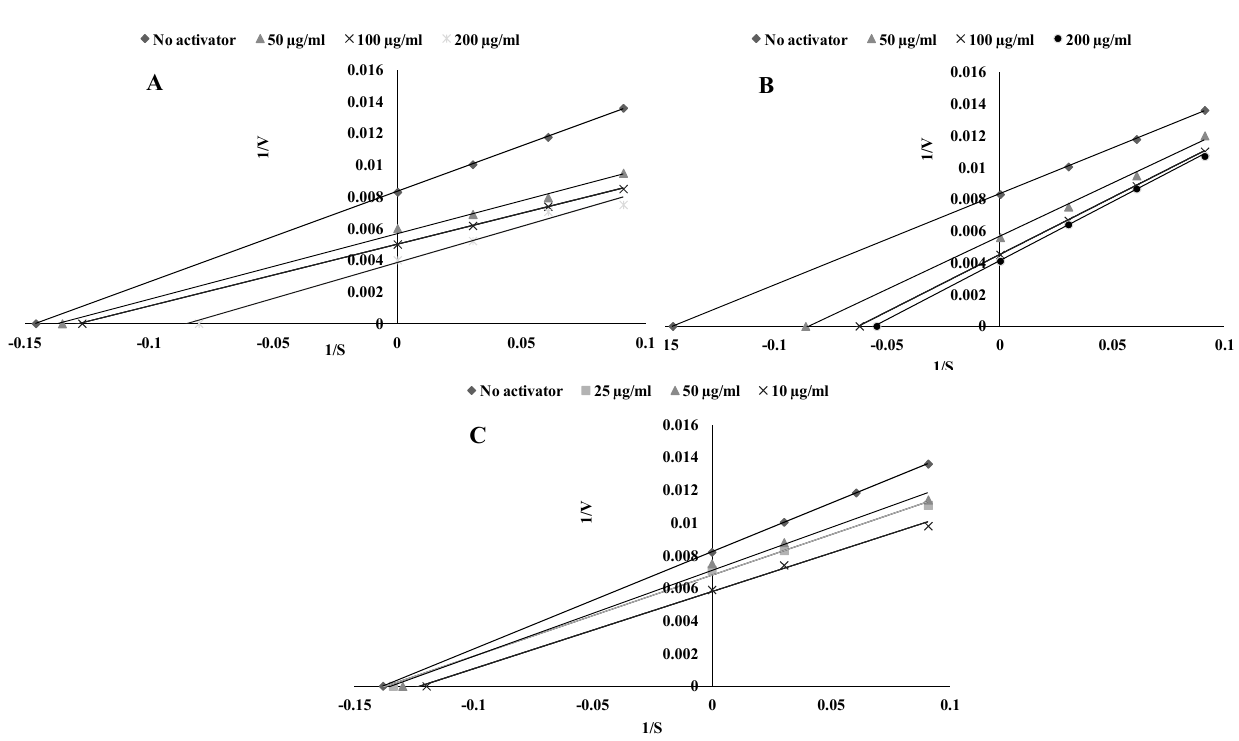
Figure 1. Activatory effect of ferulic acid ( A ), syringic acid ( B ) and trans -cinnamic acid ( C ) on thyroid peroxidase TPO activity. Plots are expressed 1/velocity versus 1/guaiacol [ μ g/mL] without or with activators in a reaction solution.